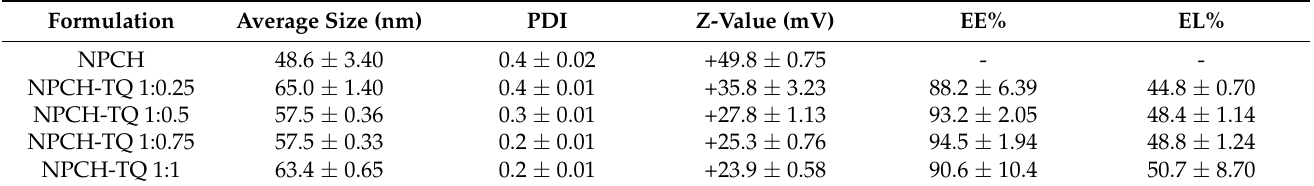
Table 1. DLS measures, encapsulation efficiency (EE%), and efficient loading (EL%) of nano-formulations.